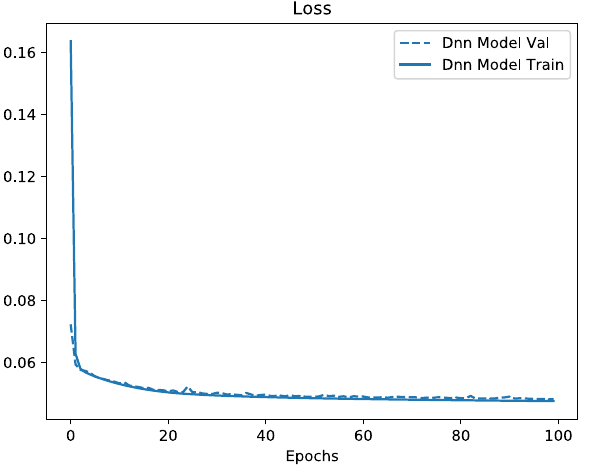
atedsothatrepresentsagoodconvergence oftheneuralnetworkparam- eters according to the number of hidden layers, neurons and batch-size